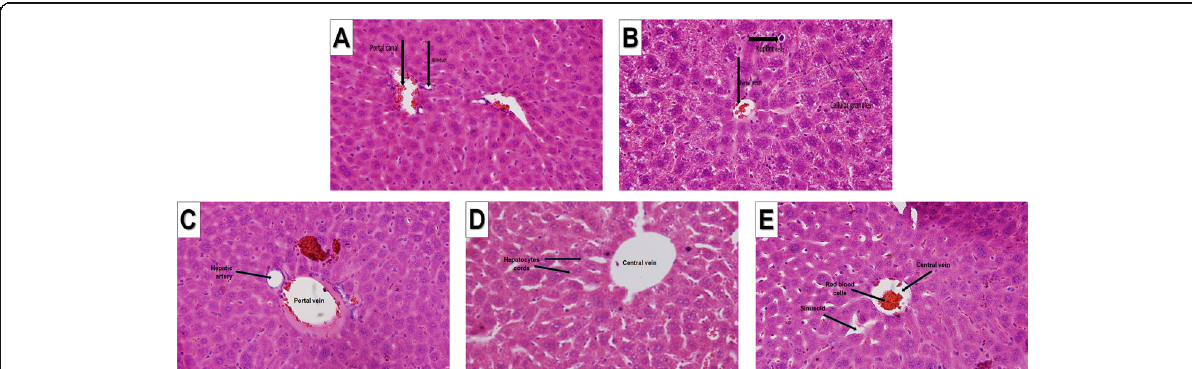
Fig. 7 Histological light micrographs represents the hematoxylin and eosin liver tissue staining of paracetamol treated, untreated control, paracetamol A. orientalis pretreated 125, 250, 500mg/kg BW mice groups (H&E X400). Paracetamol treated ( a ), untreated control ( b ), paracetamol A. orientalis pretreated 125 ( c ), paracetamol A. orientalis pretreated 250 ( d ), paracetamol A. orientalis pretreated 500 ( e ). Note that the liver structure is almost normalized in A. orientalis -pretreated mice groups compared to paracetamol treated